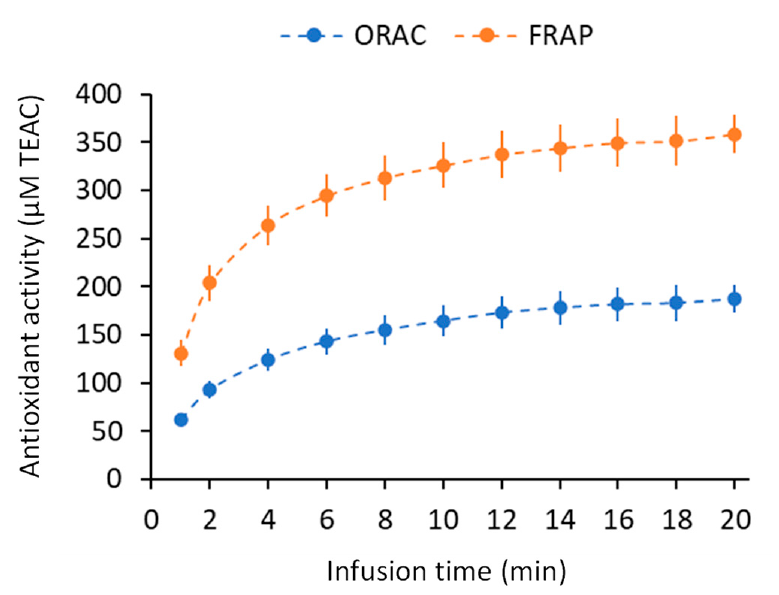
Figure 4. Variation of ORAC and FRAP antioxidant capacity expressed in µM of Trolox-C equivalent Antioxidant Capacity (µM TEAC).